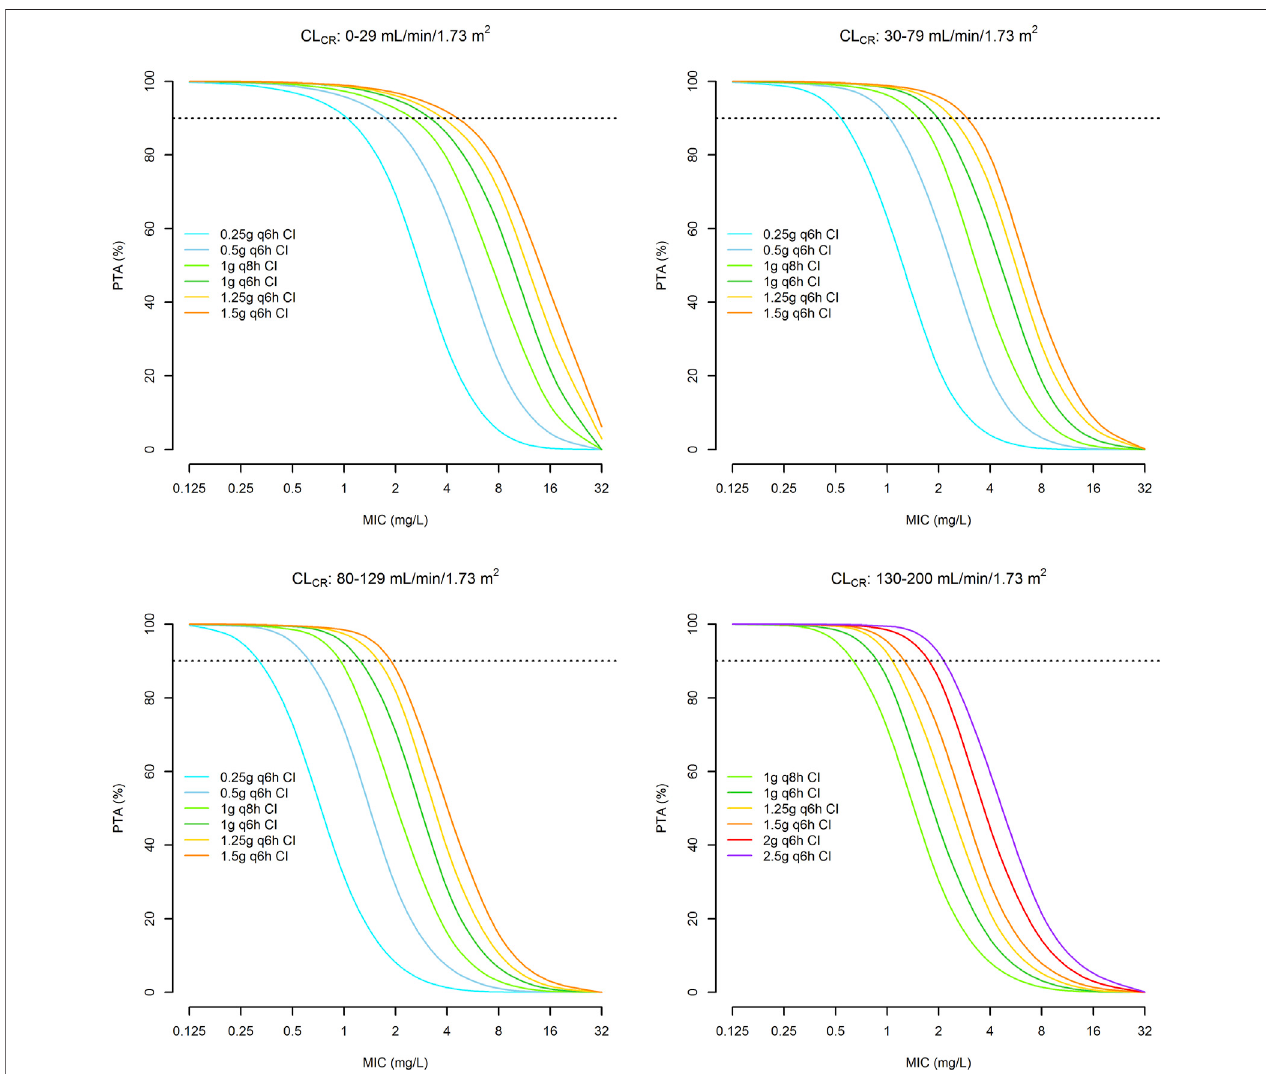
FIGURE 5 | Probability of achieving a Css/MIC value of ≥ 4.63 with continuous infusion dosages of meropenem in relation to different classes of renal function and the MIC values. Horizontal dotted line identi fi es the threshold for optimal PTA ( ≥ 90%).